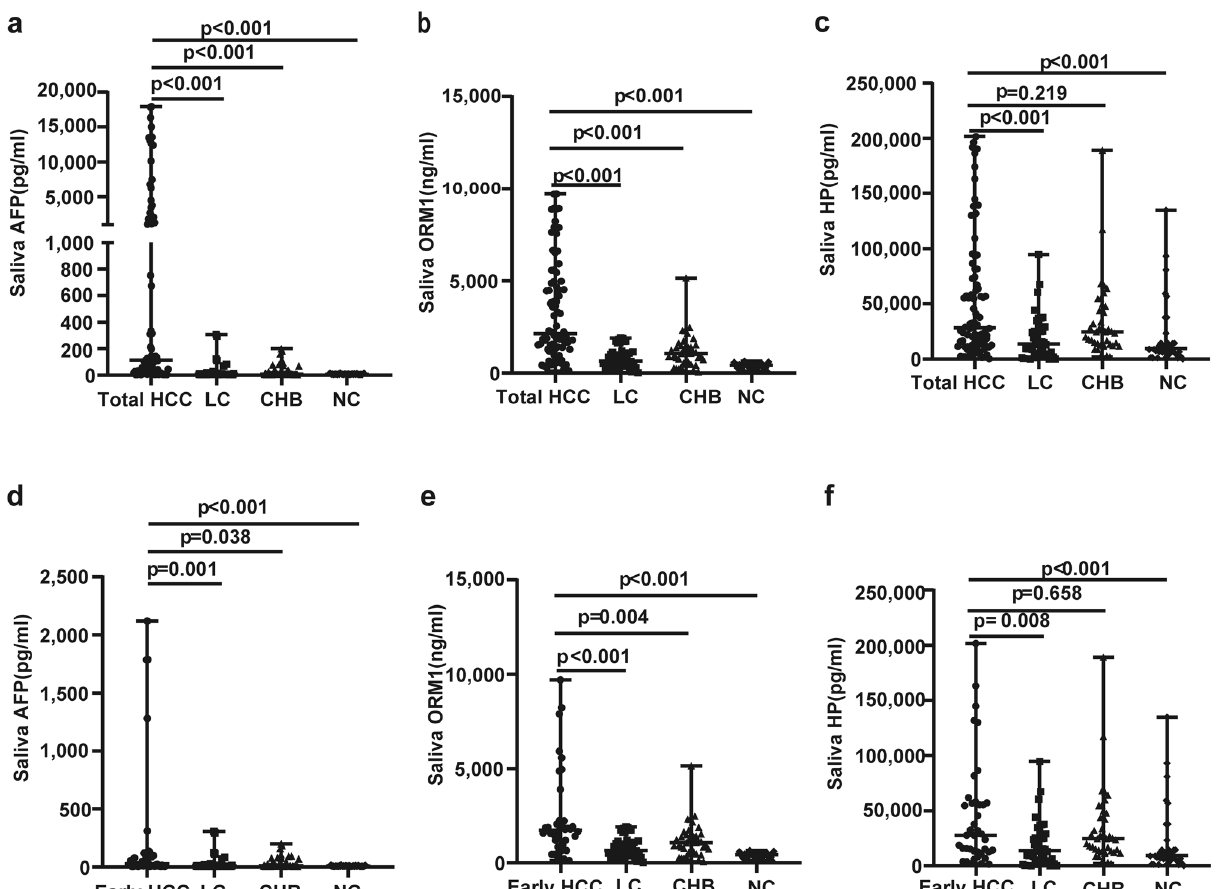
Figure 3. Elisa verification. ( a ) Salivary AFP expression in total HCC, LC, CHB and NC groups. ( b ) Salivary ORM1 expression in total HCC, LC, CHB and NC groups. ( c ) Salivary HP expression in HCC, LC, CHB and NC groups. ( d ) Salivary AFP expression in early HCC, LC, CHB and NC groups. ( e ) Salivary ORM1 expression in early HCC, LC, CHB and NC groups. ( f ) Salivary HP expression in early HCC, LC, CHB and NC groups. AFP α-fetoprotein, HP Haptoglobin, ORM1 Orosomucoid1, HCC hepatocellular carcinoma, LC liver cirrhosis, CHB chronic viral hepatitis B, NC normal control. Data are shown as median with